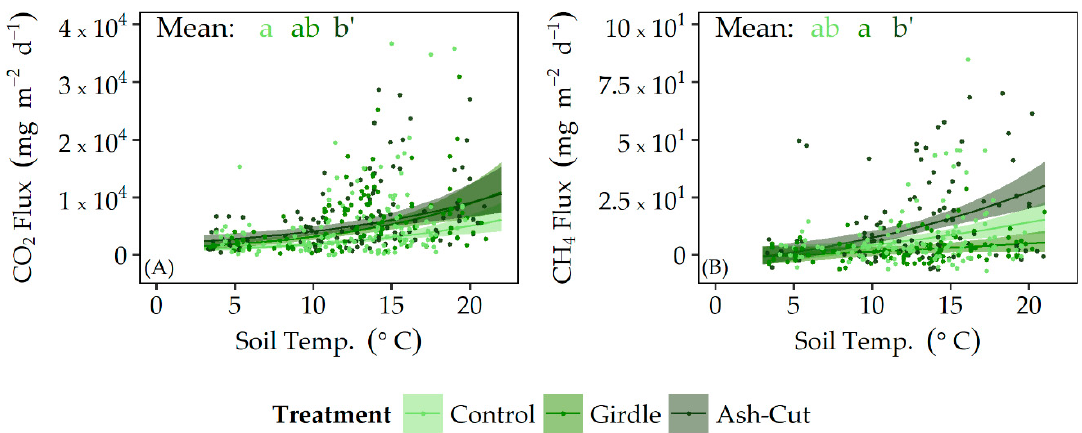
Figure 3. ( A ) Predicted soil CO 2 flux response to soil temperature and water level ( WL col ) for each treatment, with shaded 95% confidence intervals [57]; ( B ) Predicted soil CH 4 flux response to soil temperature and water level ( WL col ) for each treatment, with shaded 95% confidence intervals. WL col was embedded, using a correlated random intercept and slope, within each LMM as an interacting fixed effect. Significant differences between treatment means are indicated by (a) and (b) at p < 0.05, where ( ′ ) indicates detection of marginally significant between-treatment means differences at p < 0.1.